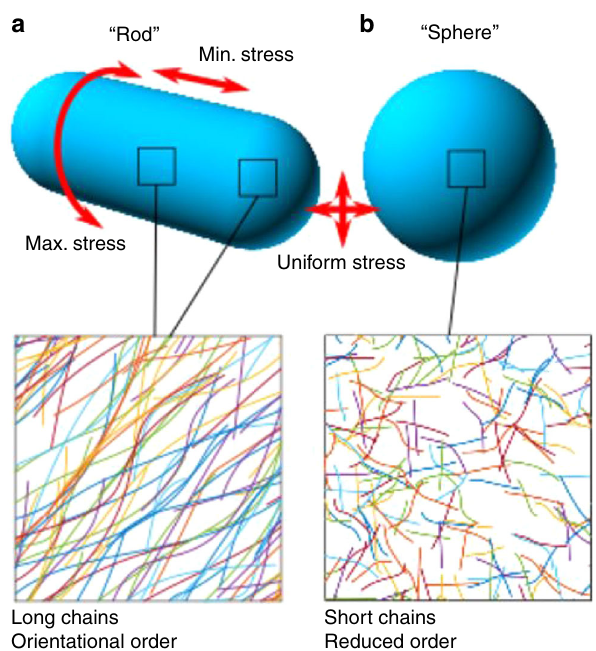
Fig. 5 Conceptual diagrams. a Peptidoglycan from rod-shaped E. coli (MG1655) is not crystalline yet has quanti fi able orientational order with chains likely to be in a circumferential direction. This corresponds to the direction of maximum stress in the cylindrical part of the cell (stress is isotropic at the poles). It contains glycans up to 200 nm long.